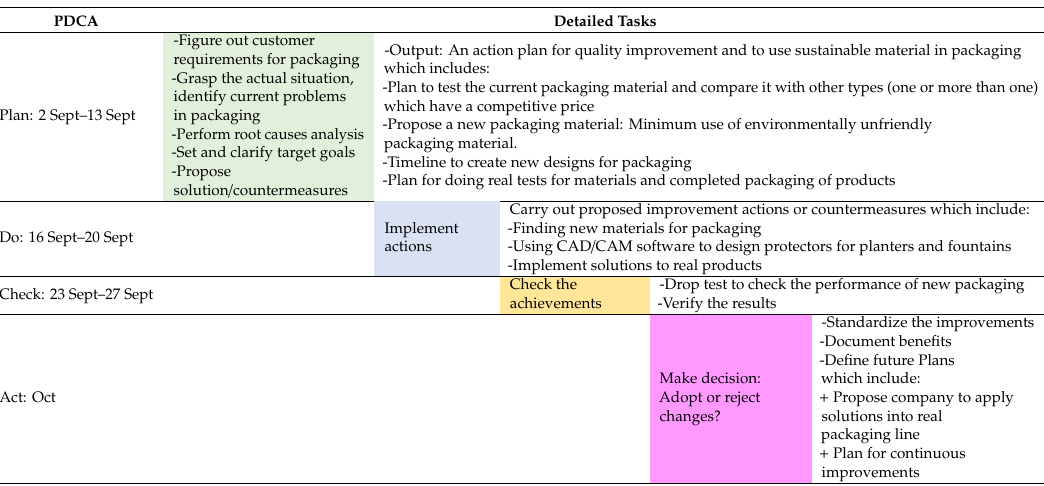
Table 4. PDCA timeline and action plan for the case study in packaging quality improvement. PDCA Detailed